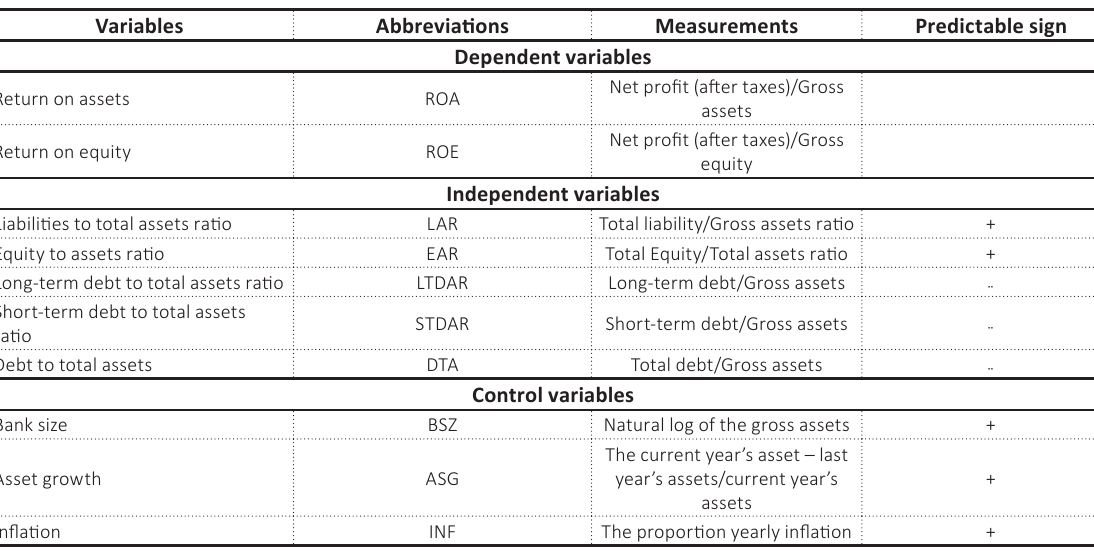
Table 1. The study variables